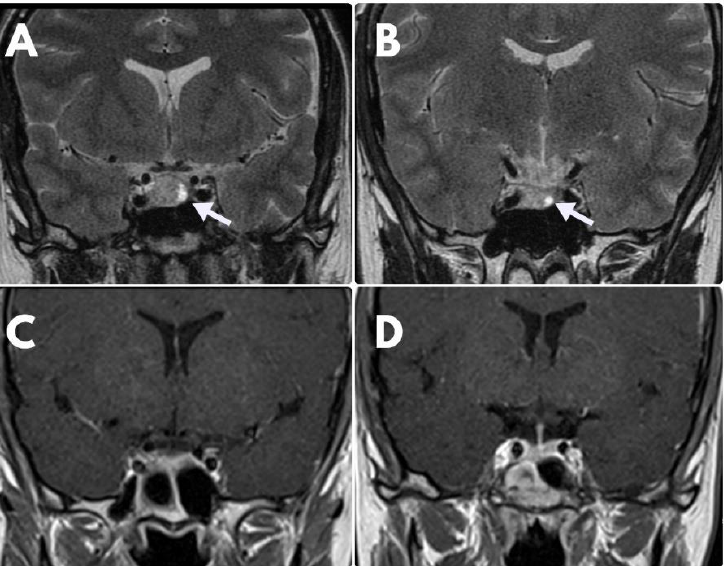
Figure 2. MRI coronal images. ( A )—MRI at the time of diagnosis—visible suspicious hyperintense area at the left side of the pituitary gland (white arrow), which was diagnosed as an adenoma. ( B )—control examination after 6 months of BRC treatment disclosed no significant regression of the lesion. ( C , D )—control MRI after operative treatment—no visible signs of